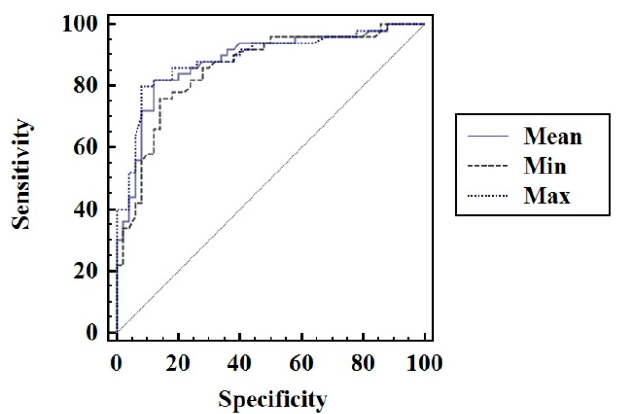
Table 3. The difference between areas under receiver operating characteristic curves (AUROCs) for the established cut-off value.